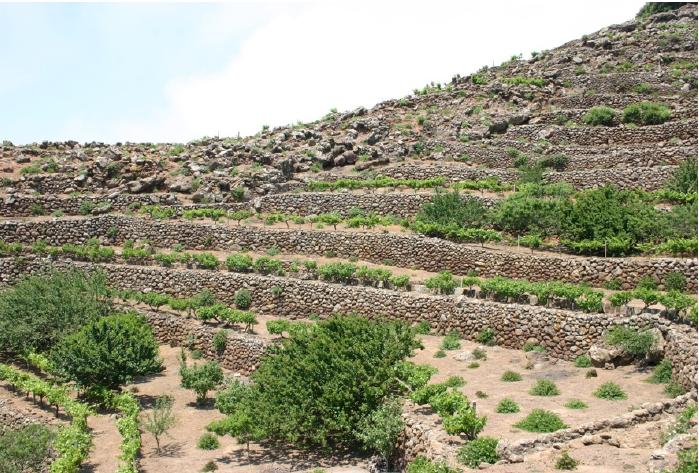
Figure 1. Traditional caper orchard on the island of Pantelleria, where sloped lands in ancient times were managed in order to obtain comfortable terraces.